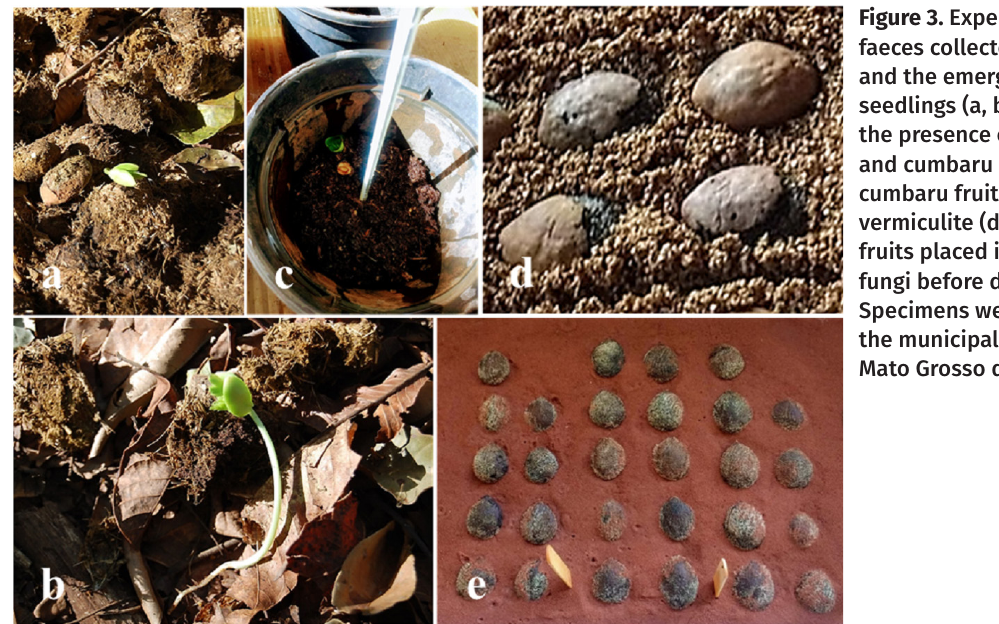
Figure 3. Experiment with faeces collected in the latrines and the emergence of cumbaru seedlings (a, b), vase with the presence of thermometer and cumbaru seedlings (c), cumbaru fruits placed in vermiculite (d), and cumbaru fruits placed in sand with fungi before disinfection (e). Specimens were collected in the municipality of Corguinho, Mato Grosso do Sul,